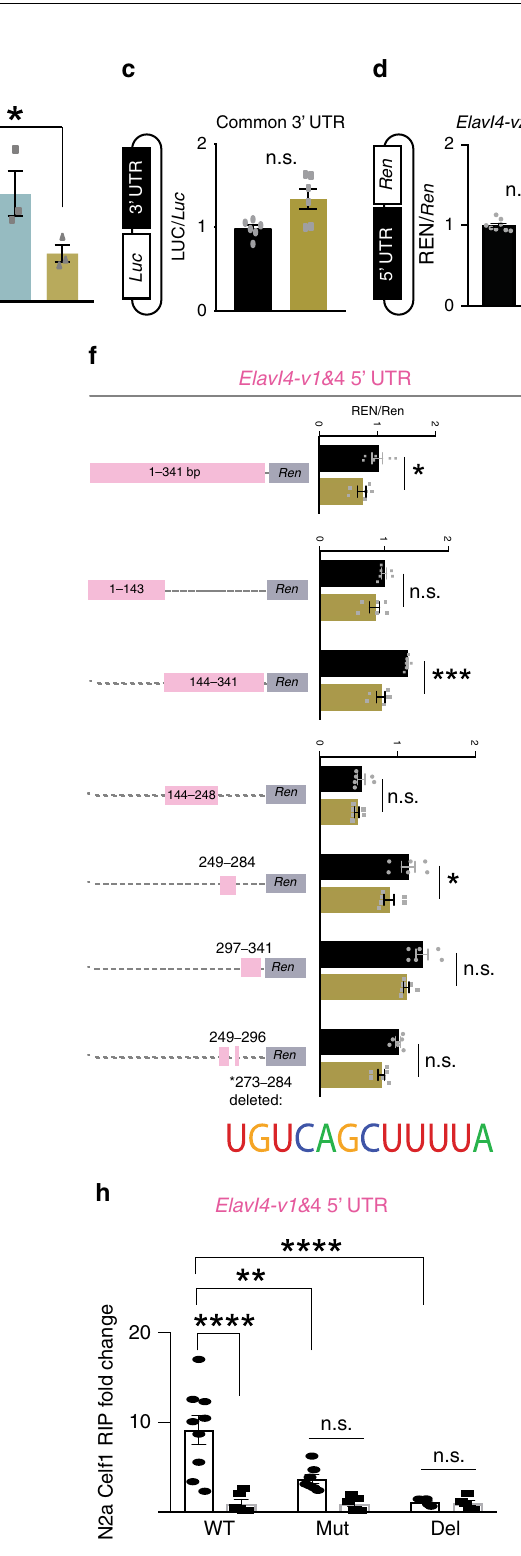
from heavier to lighter fractions (Supplementary Fig. 5e), while Elavl4-v3 was too low in polysome fractions to yield meaningful suf fi cient to disturb Elavl4 mRNA in polysomes. Meanwhile, in the Celf1 knockdown condition in N2a cells (Supplementary Figs. 4d, 6a), Elavl4-v1&4 isoform presence on heavy polysomes increased relative to free, 40S-60S-80S